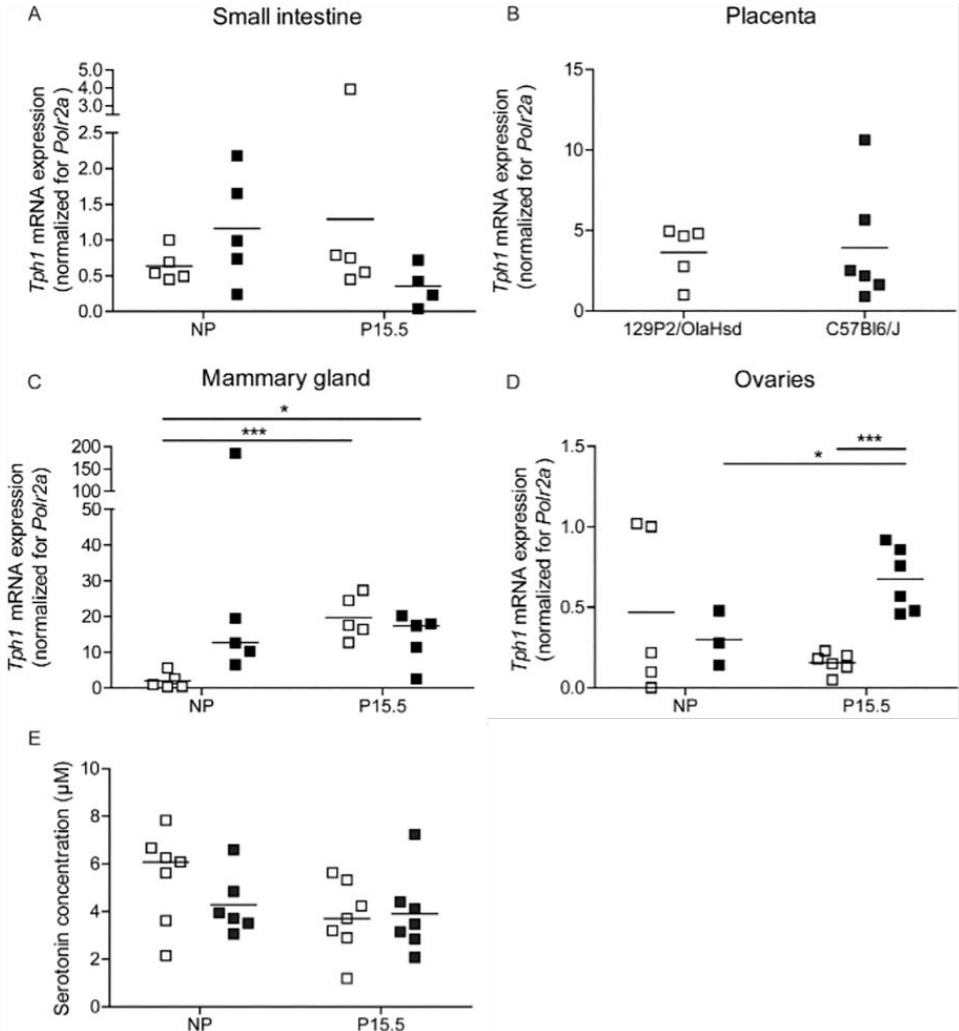
Figure 5. Regulation of Tph1 expression in 129P2/OlaHsd ( □ ) and C57BL6/J mice ( ■ ). Each point in ( A – D ) represents the Q‑RT‑PCR measurement of material sampled from one mouse; mean values are represented by horizontal bars. Significance of differences between groups was calculated using Student’s‑ t ‑tests. * p < 0.05, *** p < 0.001. Tph1 mRNA expression was not significantly different in the two mouse strains in small intestine ( A ), placenta ( B ), and mammary glands ( C ). However, in ovaries, Tph1 levels are more upregulated in C57Bl6/J mice as compared to 129P2/OlaHsd mice ( D ). Data were normalized for the Polr2a and expressed relative mRNA level of the non-pregnant 129P2/OlaHsd group ( E ): Blood serotonin levels are similar in all conditions.